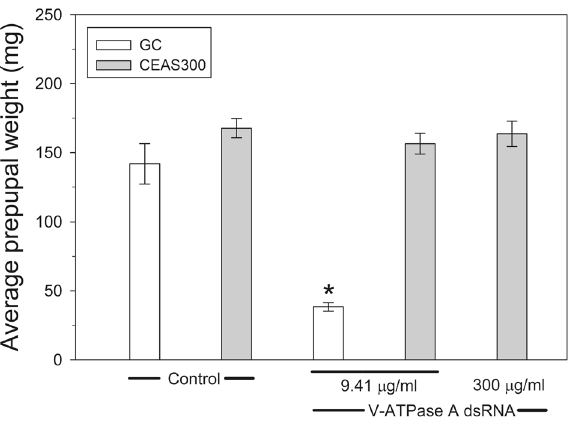
Figure 1. Average weight (in mg) of GC and CEAS prepupae when exposed to control, 9.41 μg/ml or 300 μg/ ml of V-ATPase subunit A dsRNA throughout larval development. Asterisk denotes significant mean weight difference ( P < 0.05, Mann–Whitney Rank Sum Test) between control and 9.41 μg/ml treatment in GC. No significant differences ( P = 0.918, Kruskal–Wallis One Way ANOVA on Ranks) between any of the treatments in CEAS 300.